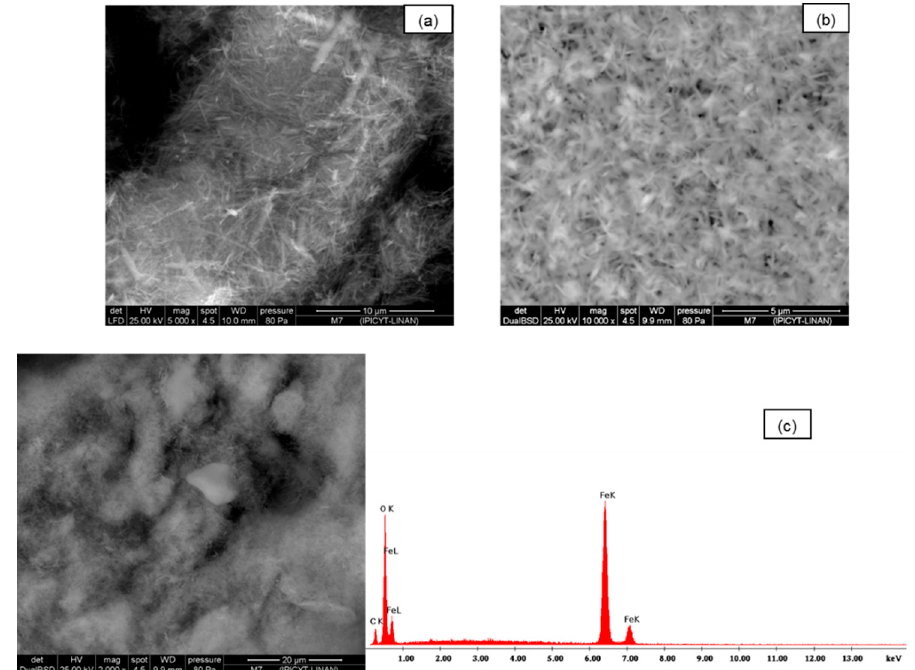
Figure 1. ( a , b ) SEM images of silica sand coated with Fe(III) untreated; ( c ) Fragment where EDS (white box) and chemical spectrograph quantification EDS of adsorbent was performed.